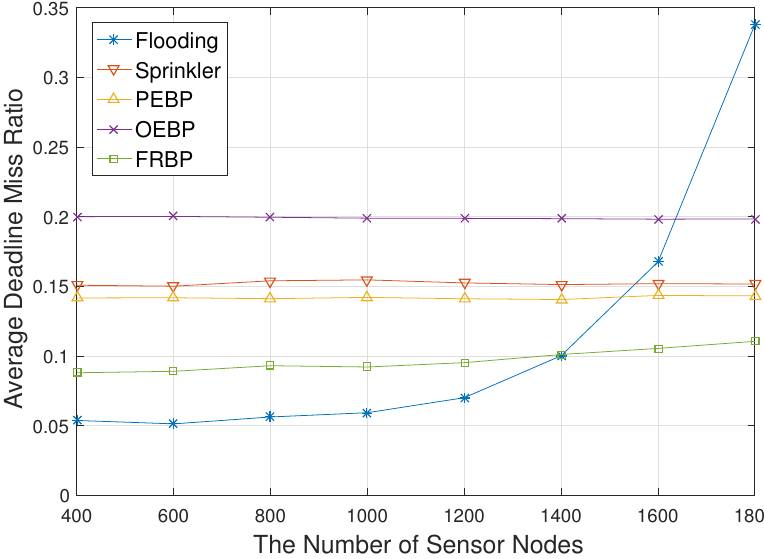
Figure 3. Deadline missed ratio impacted by the number of nodes. PEBP, Probability-based Energy-efficient Broadcast Protocol; OEBP, Opportunistic EBP; FRBP, ( m , k )-firm-based Real-time Broadcast Protocol.